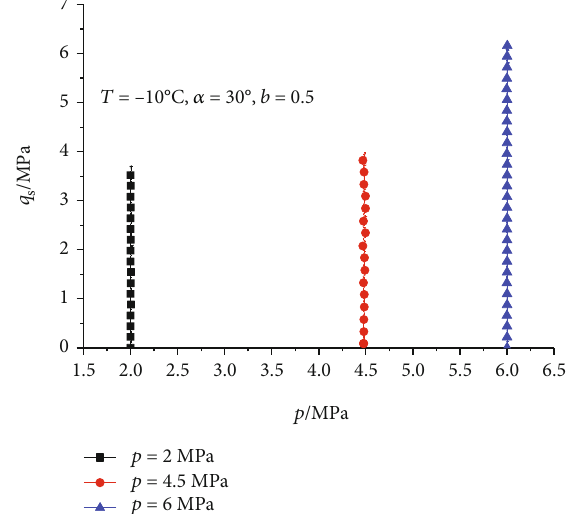
Figure 7: Relationships between mean principal stress and shear stress under di ff erent mean principal